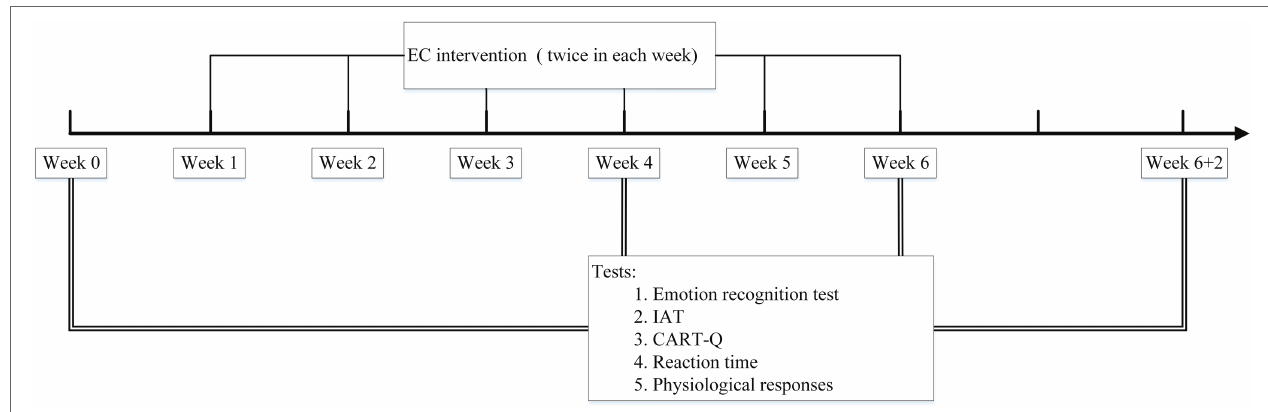
FIGURE 1 | The timeline of the EC intervention and the tests. The EC intervention was conducted twice a week for 6 weeks (Week 1–6). The measures were tested before the intervention (Week 0), during the intervention (Week 4), at the end of the intervention (Week 6), and post intervention (Week 6 +